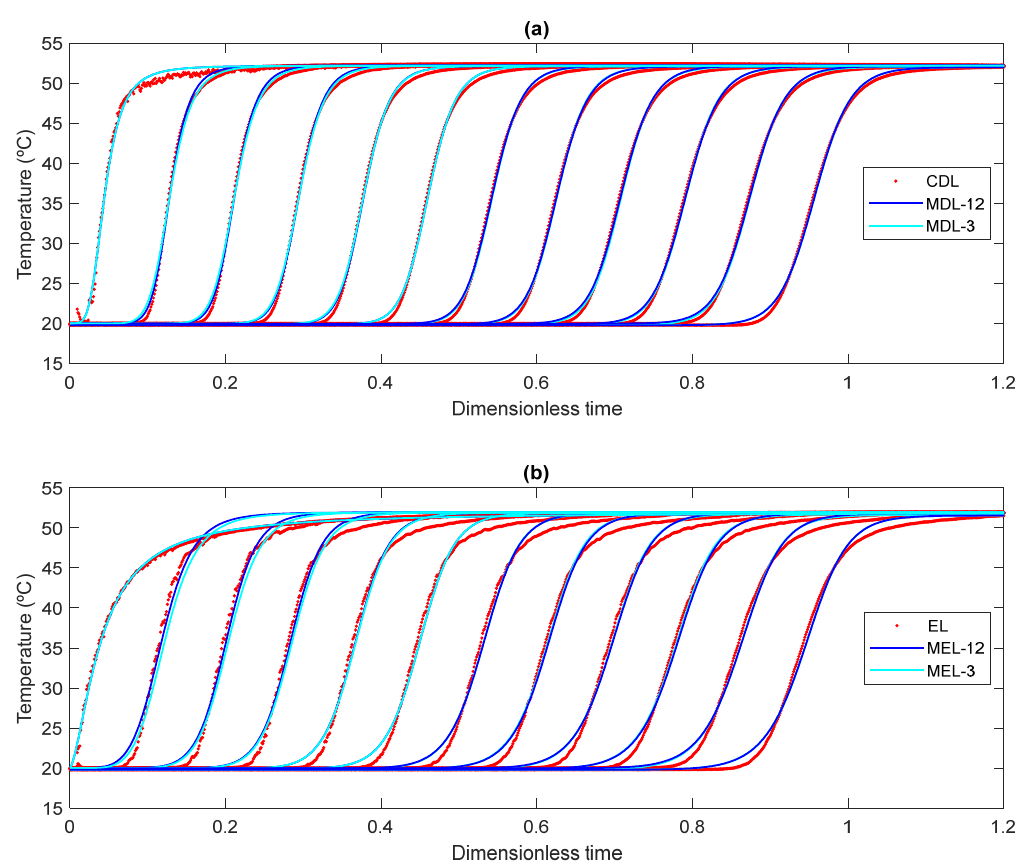
Figure 3. Temperature profile evolution at each TC position. Results with CD ( a ) and E ( b ), both at low flow rate: experimental data, models with 12 TC and models with 3 TC.